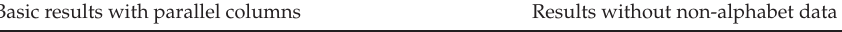
Table 2. P/R results of re-OCRing in comparison to old OCR. Basic results with parallel